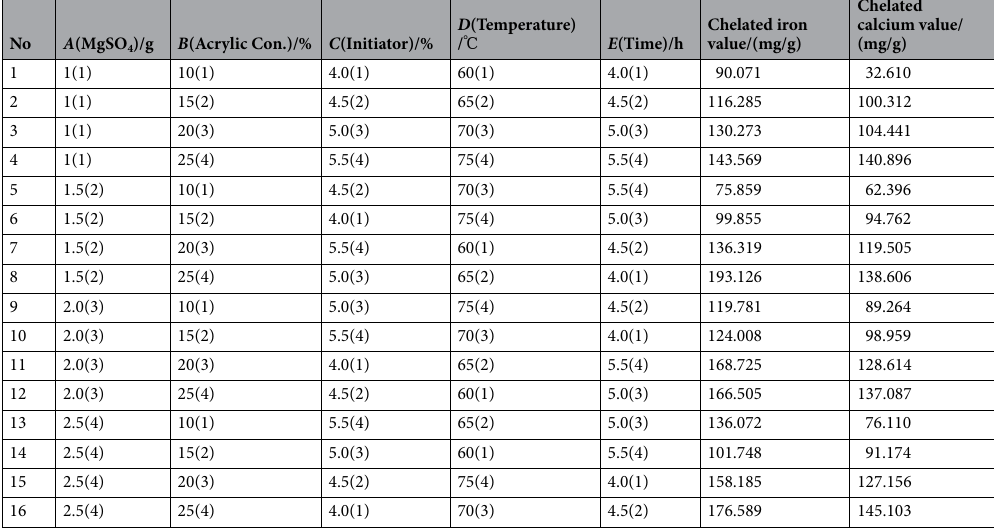
Table 1. The orthogonal Layout.